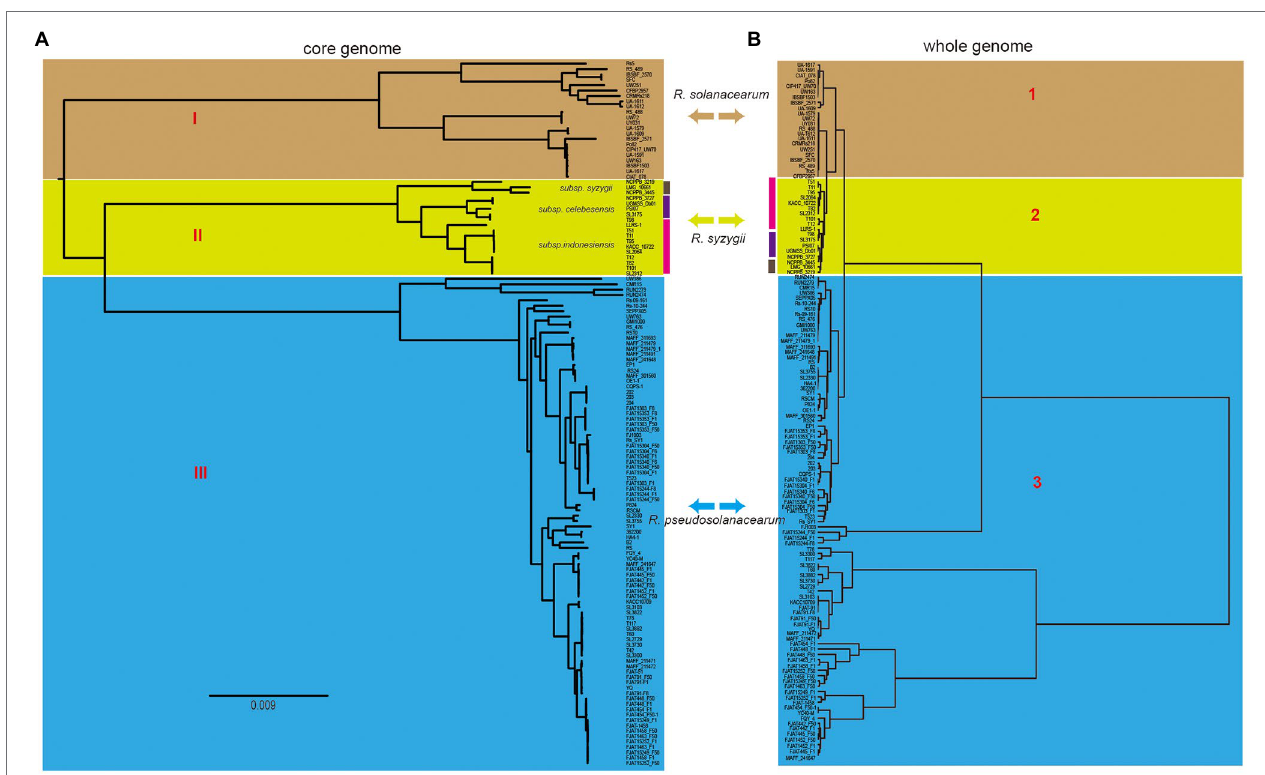
FIGURE 3 | Comparison of two phylogenetic trees constructed using core genome and whole genome, respectively. (A) Core genome tree was based on 1,129 core genes of 131 strains, and different cores represent three different species, which was linked with that in the whole genome tree (right). (B) Whole genome tree could also be divided into three groups, the colors linked with that in core genome tree (left). Bidirectional arrows in the middle represents the same species in these two